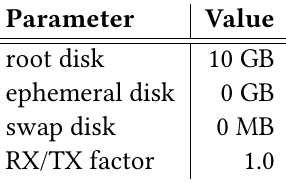
Table 2: Fixed parameters for defined